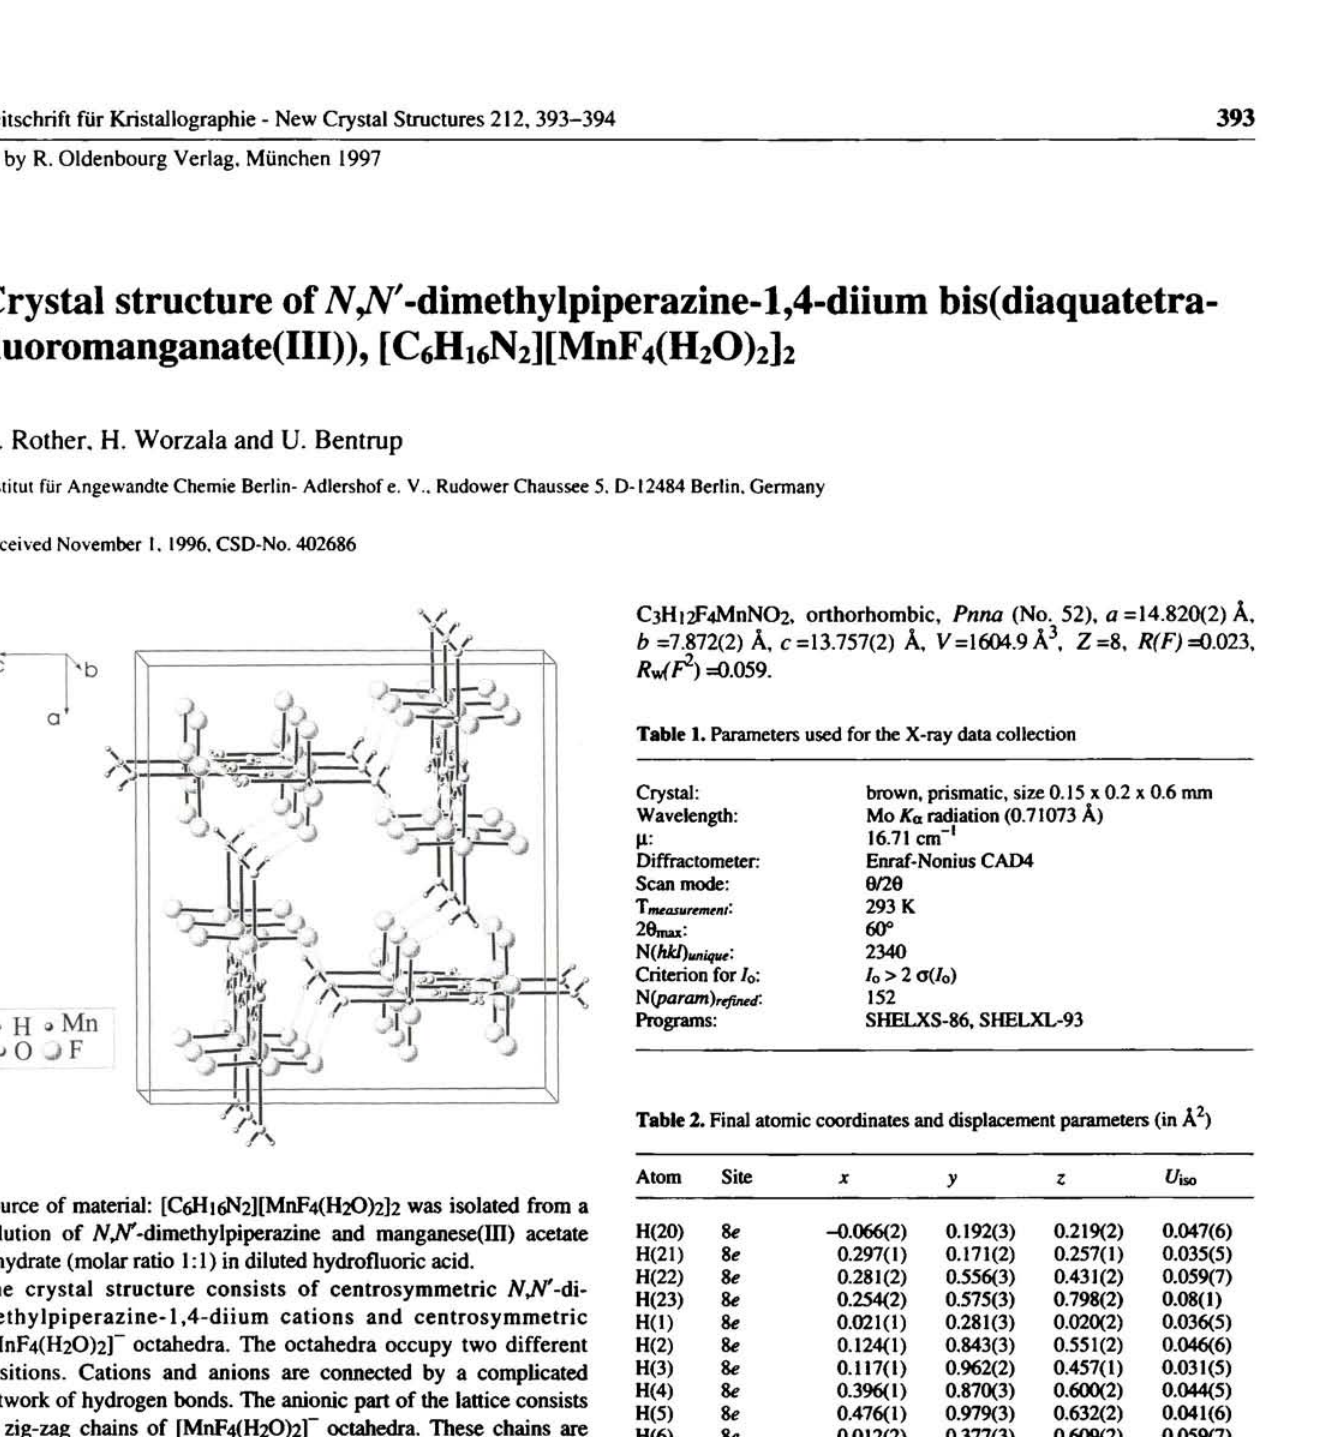
Table 2. Final atomic coordinates and displacement parameters (in A 2 )